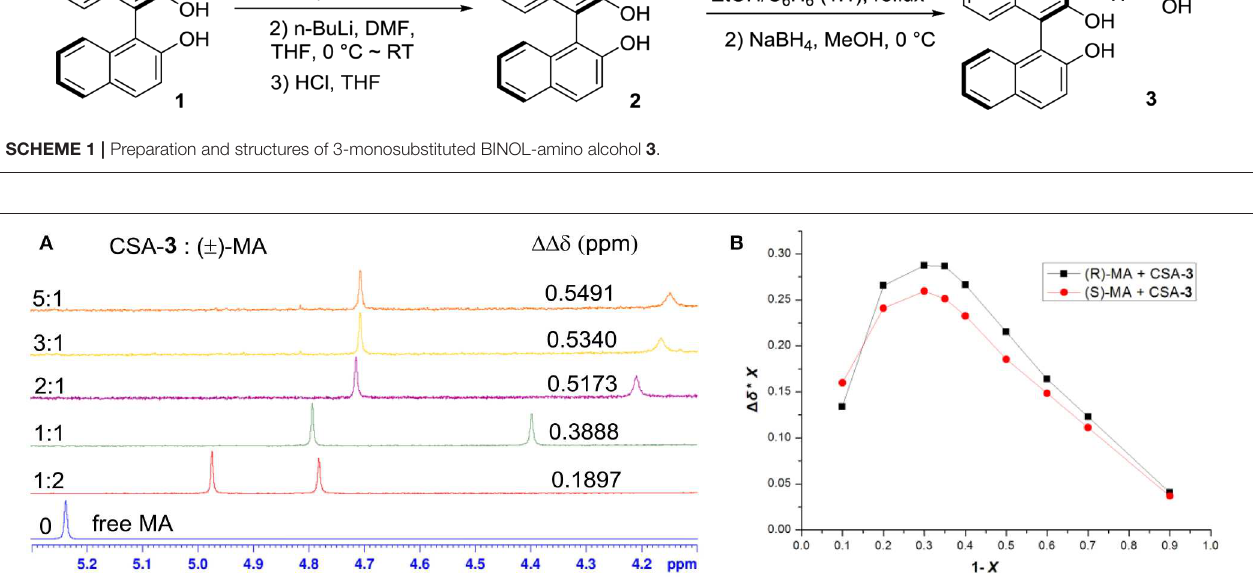
FIGURE 1 | (A) Overlaid partial 1 H NMR spectra and nonequivalent chemical shifts of α -H of ( ± )–mandelic acid (MA) with various molar ratio in the presence of CSA 3 in CDCl 3 at room temperature. (B) Job plots of CSA- 3 with (R)-MA and (S)-MA. 1 δ stands for the chemical shift change of the α -H proton of (R)- and (S)-MA in the presence of CSA- 3 . X stands for the molar fraction of the CSA- 3 ( X = [CSA- 3 ]/[CSA- 3 ] + [MA]). The total concentration is 10mM in CDCl 3 .